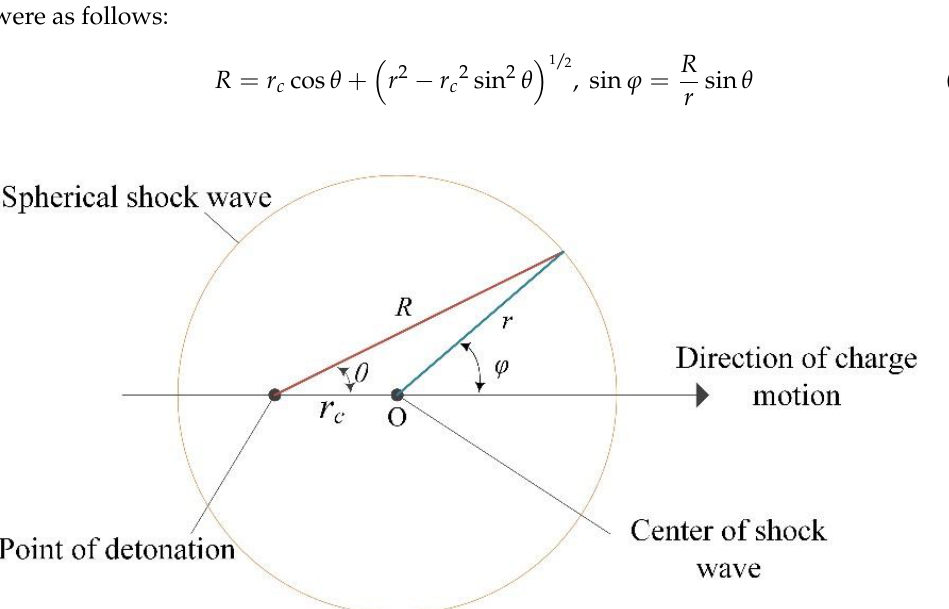
Figure 11. Shock wave model of a moving charge explosion. According to the equation of Rankine–Hugoniot [26], there is a relationship between the shock wave velocity and shock wave overpressure, as given in Equation (8). The